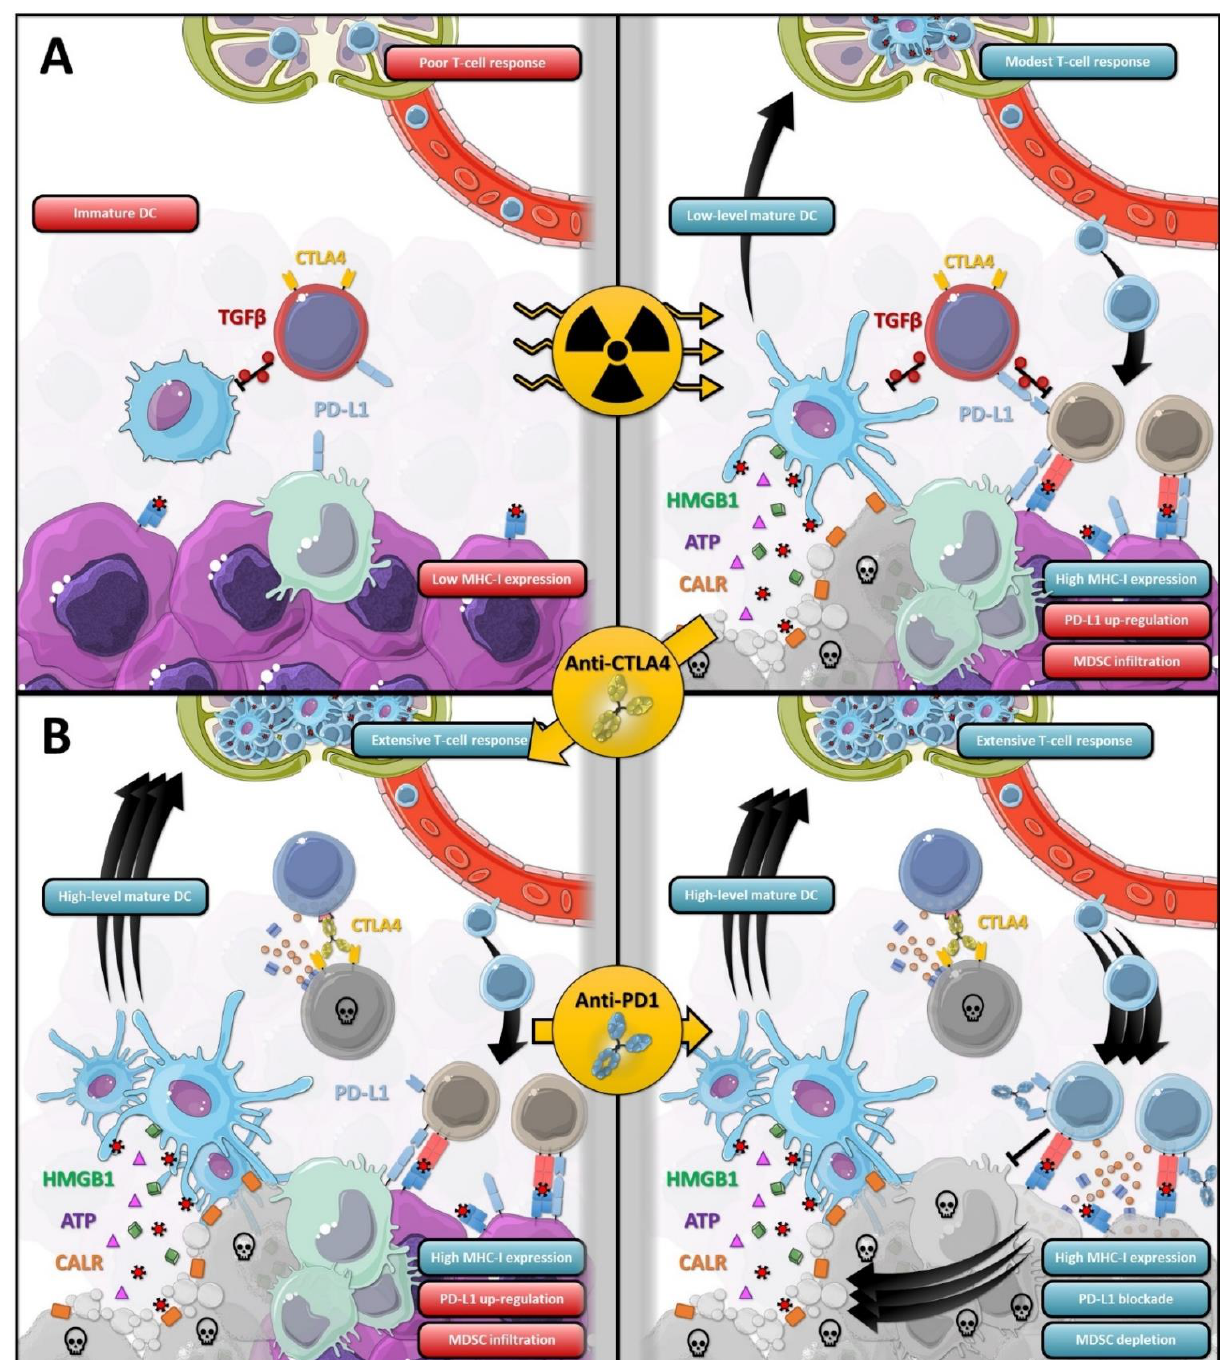
Figure 1. The biological consequences of RT and the synergism effects of RT-ICI association. ( A ) RT induce ICD leading to DC maturation and activation. However, DC activation is limited by Treg (red cell) through TGFβ secretion. Despite the MHC-1 upregulation, CD8 + T-cells remain inhibited by RT-related PD-L1 upregulation, MDSC infiltration and TGFβ secretion. ( B ) Anti-CTLA4 antibodies induce Treg depletion by ADCC, and DC activity is increased. On the other hand, CD8 + T-cells are still inhibited by PD-1/PD-L1 axis. It is only through the addition of anti-PD-1 or anti-PD-L1 antibodies that an effective immune response can be restored. A virtuous cycle is set up. ATP, adenosine triphosphate; CALR, calre- ticulin; CTLA4, cytotoxic T-lymphocyte-associated protein 4; DC, dendritic cell; HMGB1, high mobility group box 1; MDSC, myeloid-derived suppressor cell; MHC-1, major histocompatibility complex class 1; PD-L1, programmed death-ligand 1; TGFβ, transforming growth factor beta. This figure was created using Servier Medical Art templates (Creative Common Attribution 3.0), https://smart.servier.com (access on 29 December 2020).